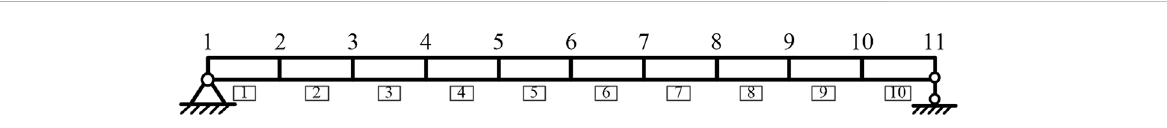
FIGURE 1 Finite element model of simply-supported